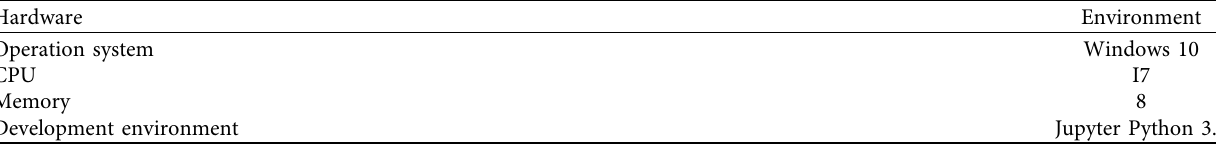
Table 5: Experiment environment setup.